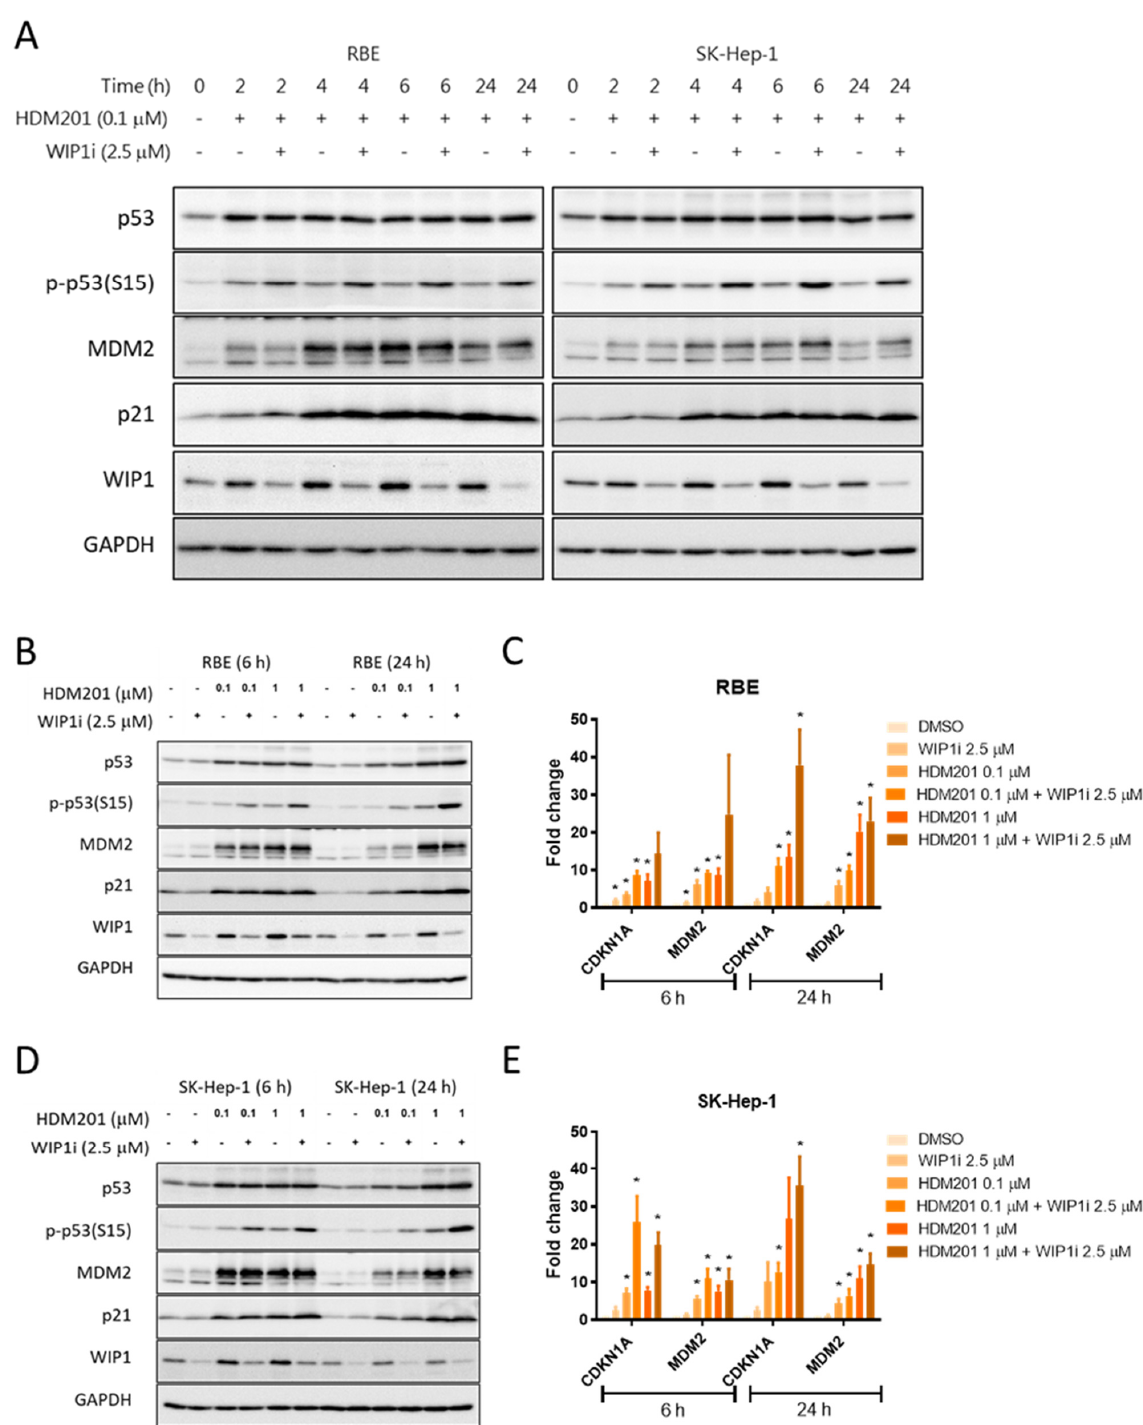
Figure 4. GSK2830371 induced p53 phosphorylation and stabilization via WIP1 inhibition. ( A ) Immunoblotting of RBE and SK-Hep-1 were treated with 0.1 µM HDM201 alone and in combination with 2.5 µM WIP1 inhibitor (WIP1i) for the indicated times. The protein expression of MDM2, WIP1, p53, p-p53, and p21 after treatment with HDM201 alone or in combination with 2.5 µM WIP1i for 6 and 24 h in RBE ( B ) and SK-Hep-1 ( D ) cells. The mRNA expression levels of CDKN1A and MDM2 increased in a dose-dependent manner following treatment with HDM201 or HDM201 + WIP1i for 6 and 24 h in RBE ( C ) and SK-Hep-1 ( E ) cells. * p < 0.05. Panels C and E show the mean ± SEM from three independent experiments performed in duplicate.